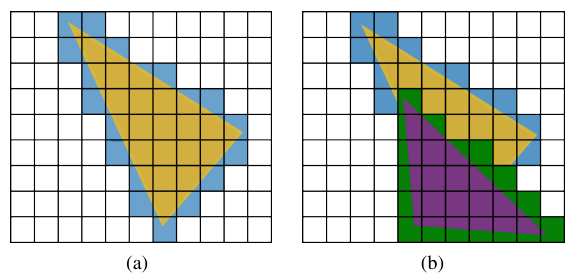
Figure 3. Determining the number of visible pixels (blue) for the yellow triangle. (a) Fully visible triangle. (b) Partially visible triangle.